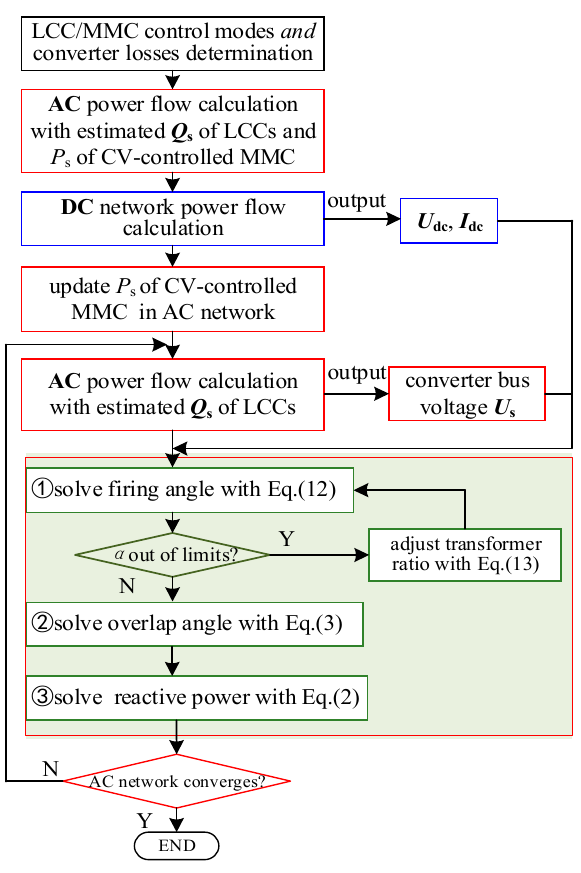
Figure 8. Flow chart of the proposed sequential power flow